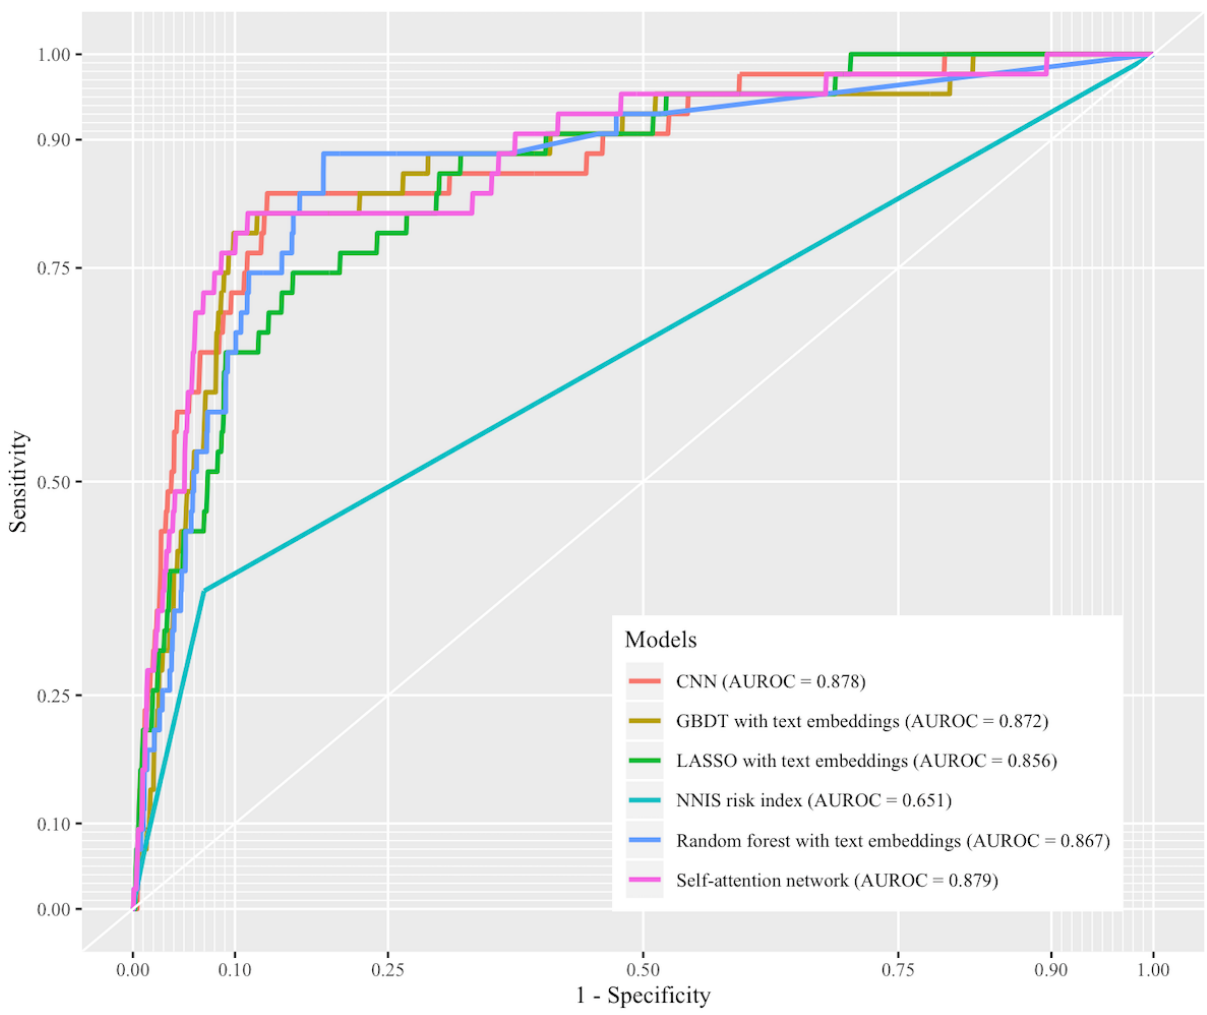
Figure 3. The receiver operating characteristic (ROC) curves of the top five models based on full training and National Nosocomial Infections Surveillance (NNIS) risk index. AUROC: area under the receiver operating characteristic curve; CNN: convolutional neural network; GBDT: gradient boosting decision tree; LASSO: least absolute shrinkage and selection